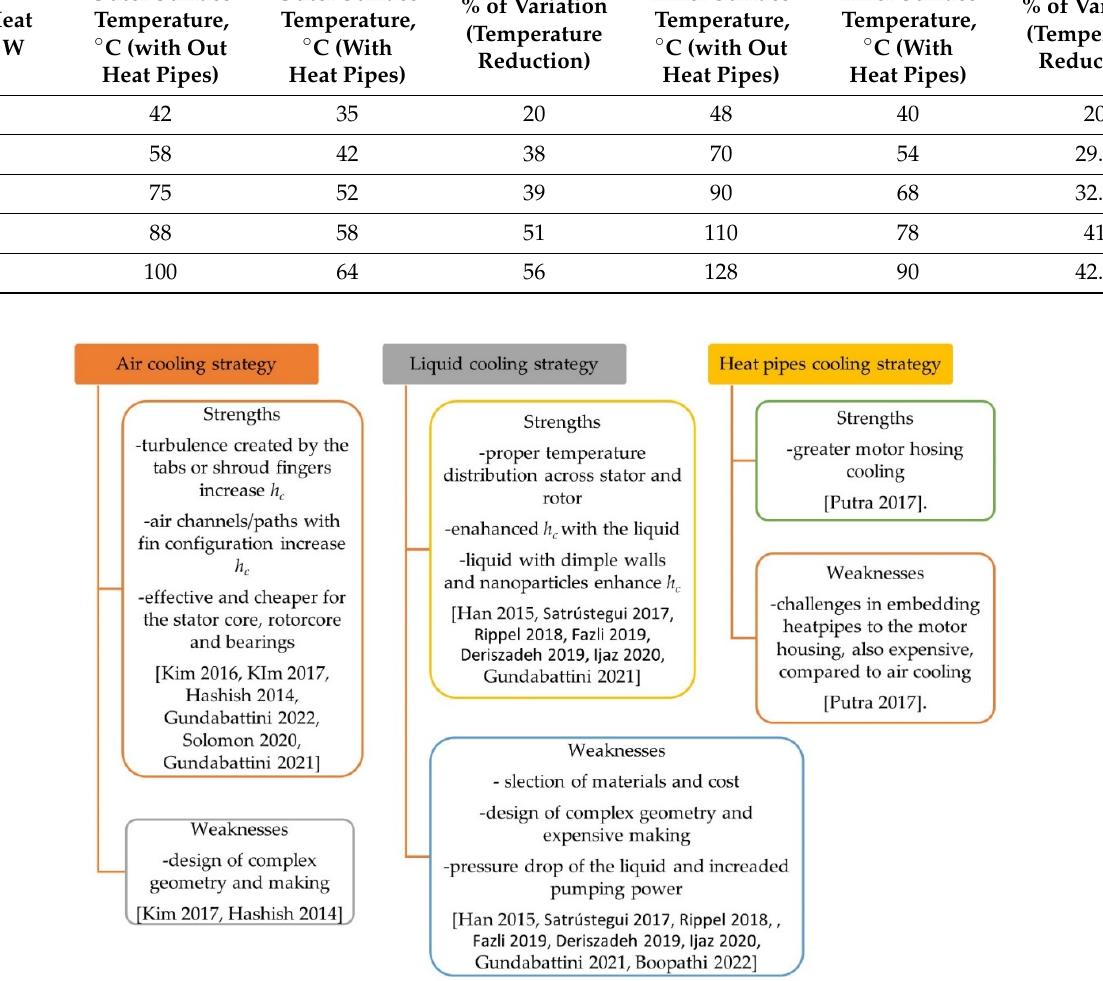
Figure 14. Cooling schemes for the components of heat sources [37–41,44–57].